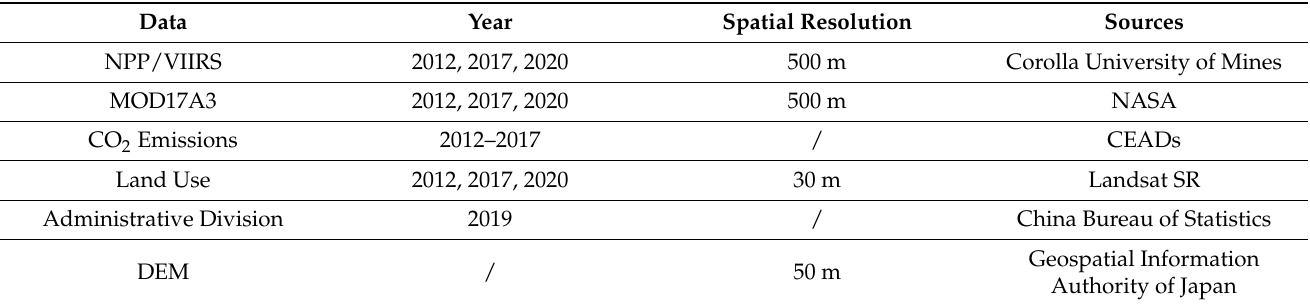
Table 1. The basic information of